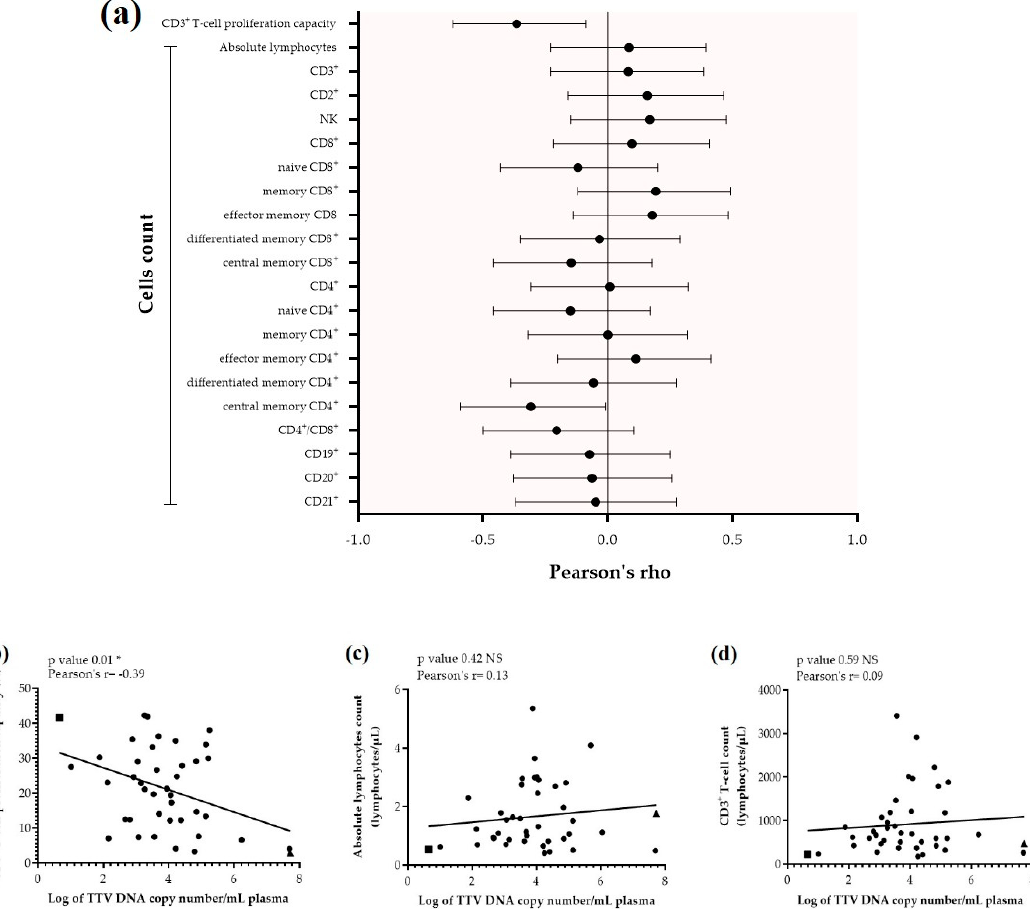
Figure 2. Overall correlation of TTV plasma viral load from 41 allo-HSCT recipients plasma versus T-cell subtype counts and CD3+ T-cell proliferation capacity ( a ). Pearson’s rho and 95% confidence interval (95% CI) for all parameters are represented by black dots and lines, respectively. Detailed correlation of TTV viral load from 41 allo-HSCT recipients’ plasma versus: ( b ) CD3+ T-cell proliferation capacity, ( c ) absolute lymphocyte count, and ( d ) CD3+ T-cell count. Extreme patients: “A” (square) and “B” (triangle), as well as the linear regression (black line) are presented. Correlation of TTV viral load ( x -axis) and cell count or CD3+ T-cell proliferation capacity ( y -axis) was determined using Pearson’s correlation coefficient. The asterisk (*) denotes statistical significance at p<0.05. Abbreviations: NK. Natural killer; PHA. Phytohemagglutinin; TTV. torque teno virus.